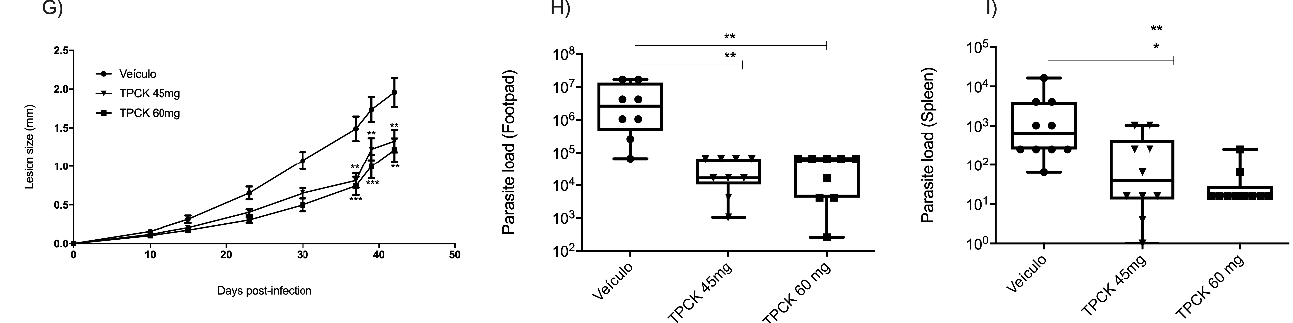
Figure 10. In vivo TPCK effect in a murine model for cutaneous leishmaniasis . BALB/c mice were infected in the right hind paw with 2 × 10 6 L. amazonensis promastigotes (Josefa strain) and treated with TPCK at 15, 30, 45, and 60 mg/kg intraperitoneally, three times per week, for a total of 10 doses. ( A ) Lesion sizes (mm): vehicle and 15 mg/kg TPCK, were measured once weekly. ( B ) Parasite loads in footpads: vehicle and 15 mg/kg TPCK. ( C ) Parasite loads in spleens: vehicle and 15 mg/kg TPCK. ( D ) Lesion sizes (mm): vehicle and 30 mg/kg TPCK were measured once weekly. ( E ) Parasite loads in footpads: vehicle and 30 mg/kg TPCK. ( F ) Parasite loads in spleens: vehicle and 30 mg/kg TPCK. ( G ) Lesion sizes (mm): vehicle and 45 and 60 mg/kg TPCK were measured once weekly. ( H ) Parasite loads in footpads: vehicle and 45 and 60 mg/kg TPCK. ( I ) Parasite loads in spleens: vehicle and 45 and 60 mg/kg TPCK. Statistical differences between mean values were evaluated by the non-parametric Student t -test: * p ≤ 0.05, ** p < 0.01, *** p < 0.001, **** p < 0.0001.